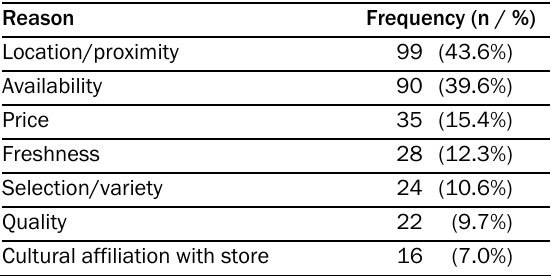
Table 7. Reason(s) Why Consumers Purchase in Specific Outlet (N=250)